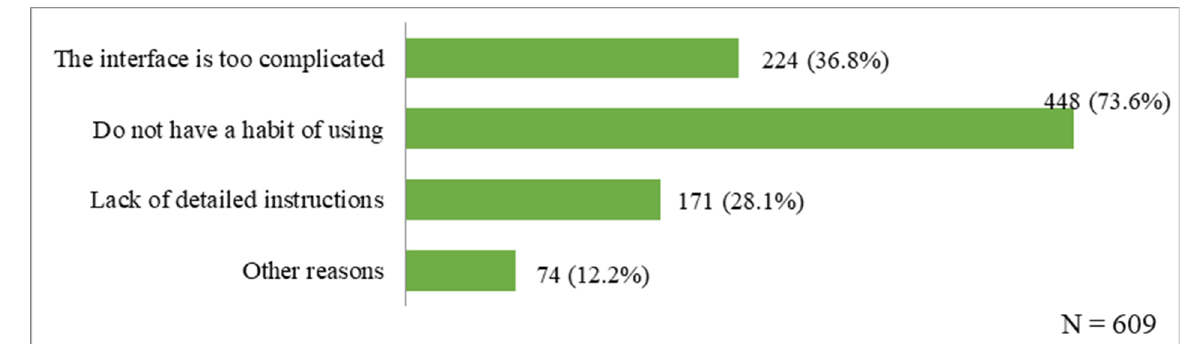
Figure 6. Main reasons for not using online services by the elderly.